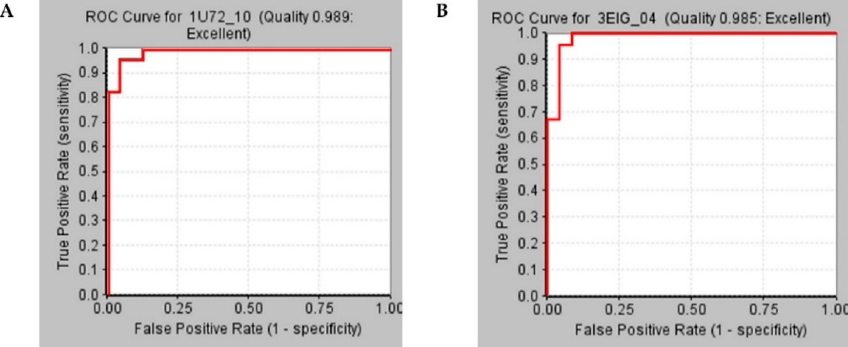
Figure 2. Receiver Operating Characteristics curves for validation of selected pharmacophore models between true positive and false-positive rates. ( A ) ROC curve shown in the red line for the WT-